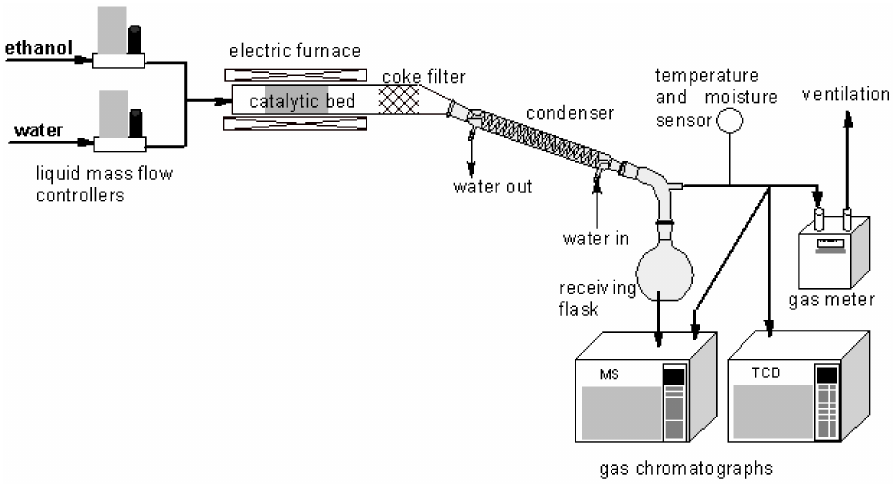
Figure 10. Scheme of the installation for the catalyst activity